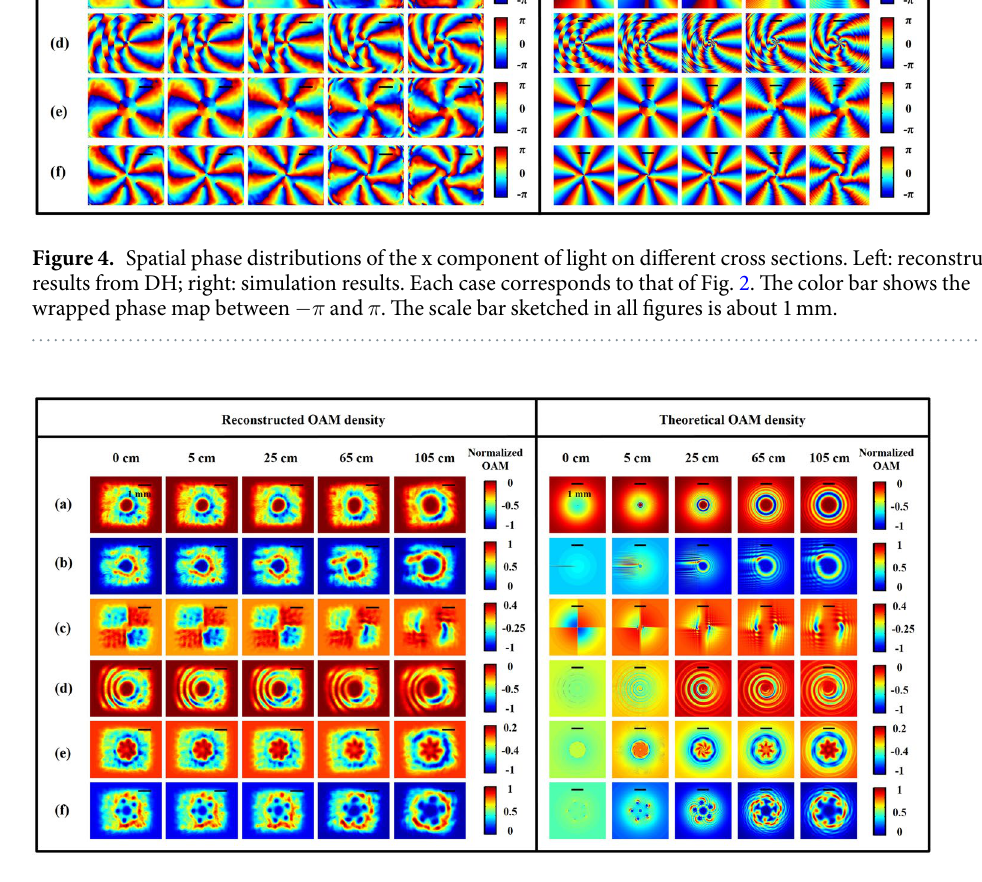
Figure 5. Spatial OAM density distributions of modulated beams on different cross sections. Left: DH reconstructed results; right: simulation results. Each case corresponds to that in Fig. 2. The color bar shows the normalized quantity of OAM densities in units of Ns / m 2 . The scale bar at the top in each figure is about 1